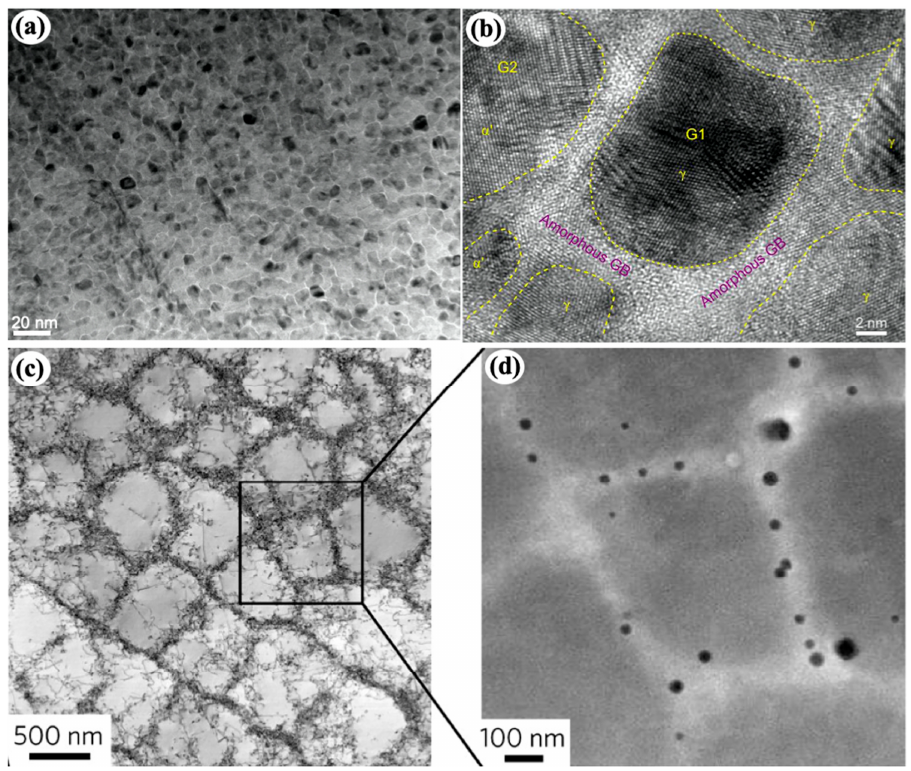
Figure 4. ( a ) A TEM image of laser-processed austenitic Had fi eld manganese steel, showing crystalline–amorphous core–shell nanostructure. ( b ) An HRTEM image showing nanocrystals and amorphous GBs [101]. ( c ) A TEM image of solidi fi cation cells in austenitic 316 L stainless steels fabricated by L-PBF technique. ( d ) HAADF-STEM image of the solidi fi cation cells showing nanoparticles segregated to the cell walls [100,102].